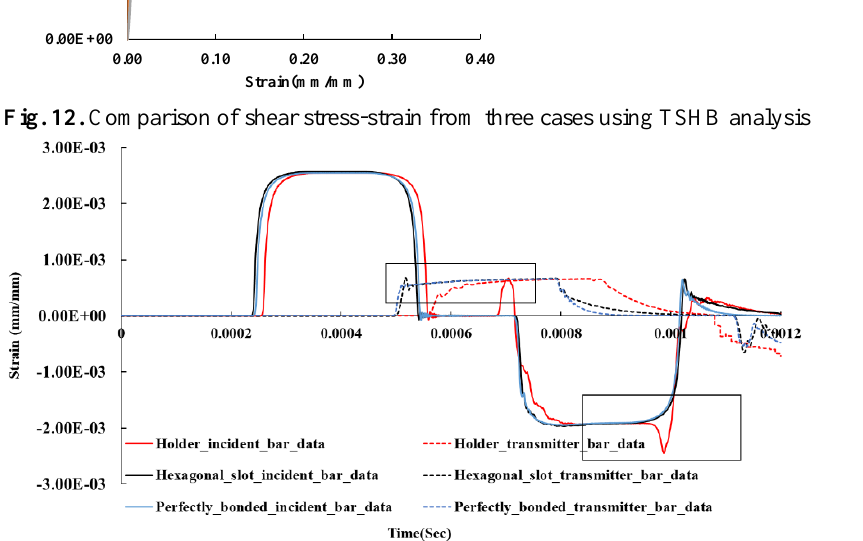
Fig.13. Comparison of Incident and transmission bar data from three